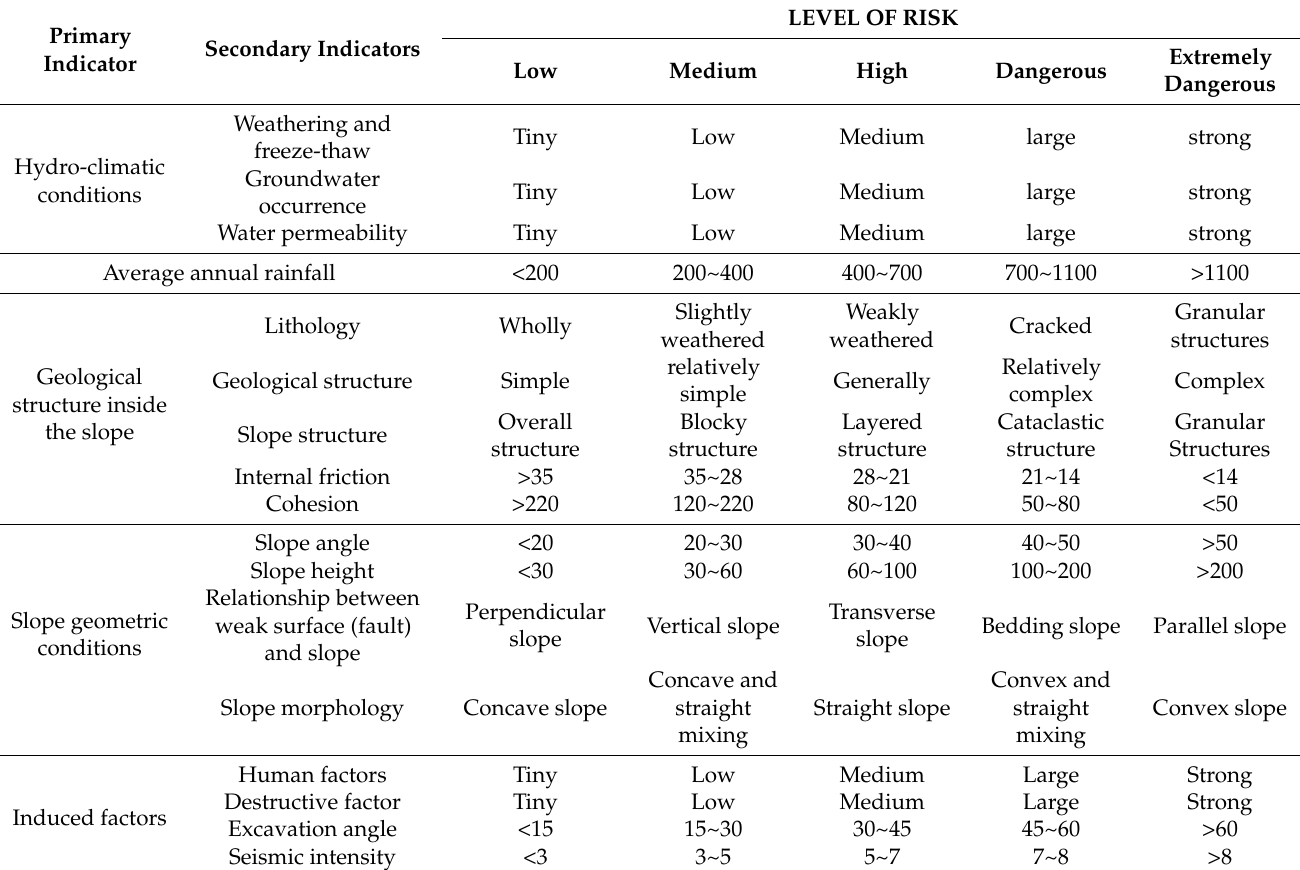
Table A1. Risk assessment index system and classification standard for slope of open-pit coal